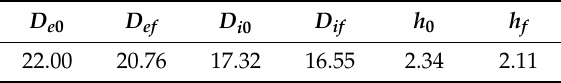
Table 3. Tube dimensions (in mm) for r = 0.1.